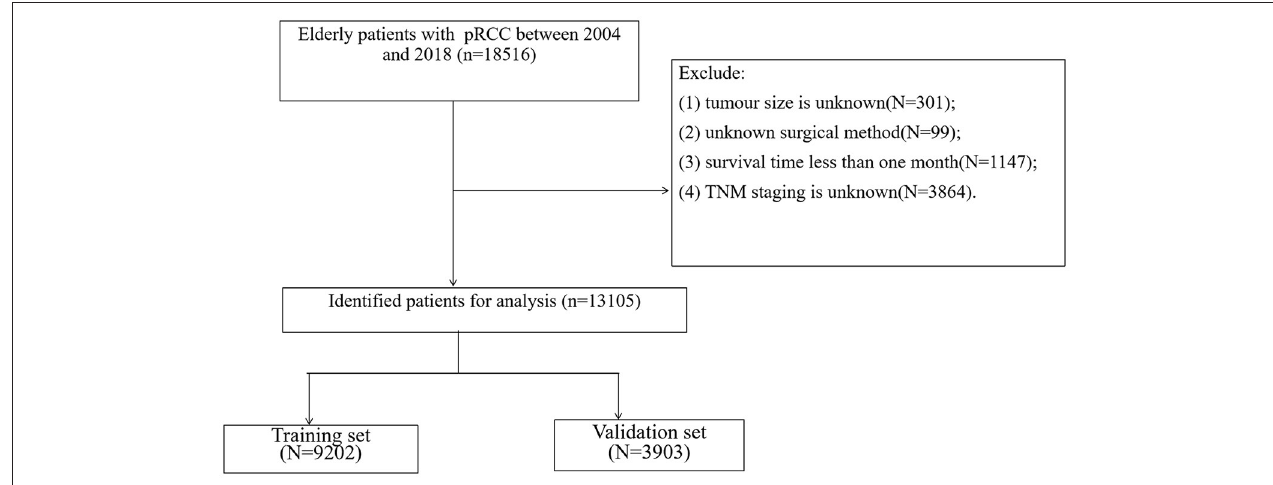
FIGURE 1 | Flowchart for inclusion and exclusion of all